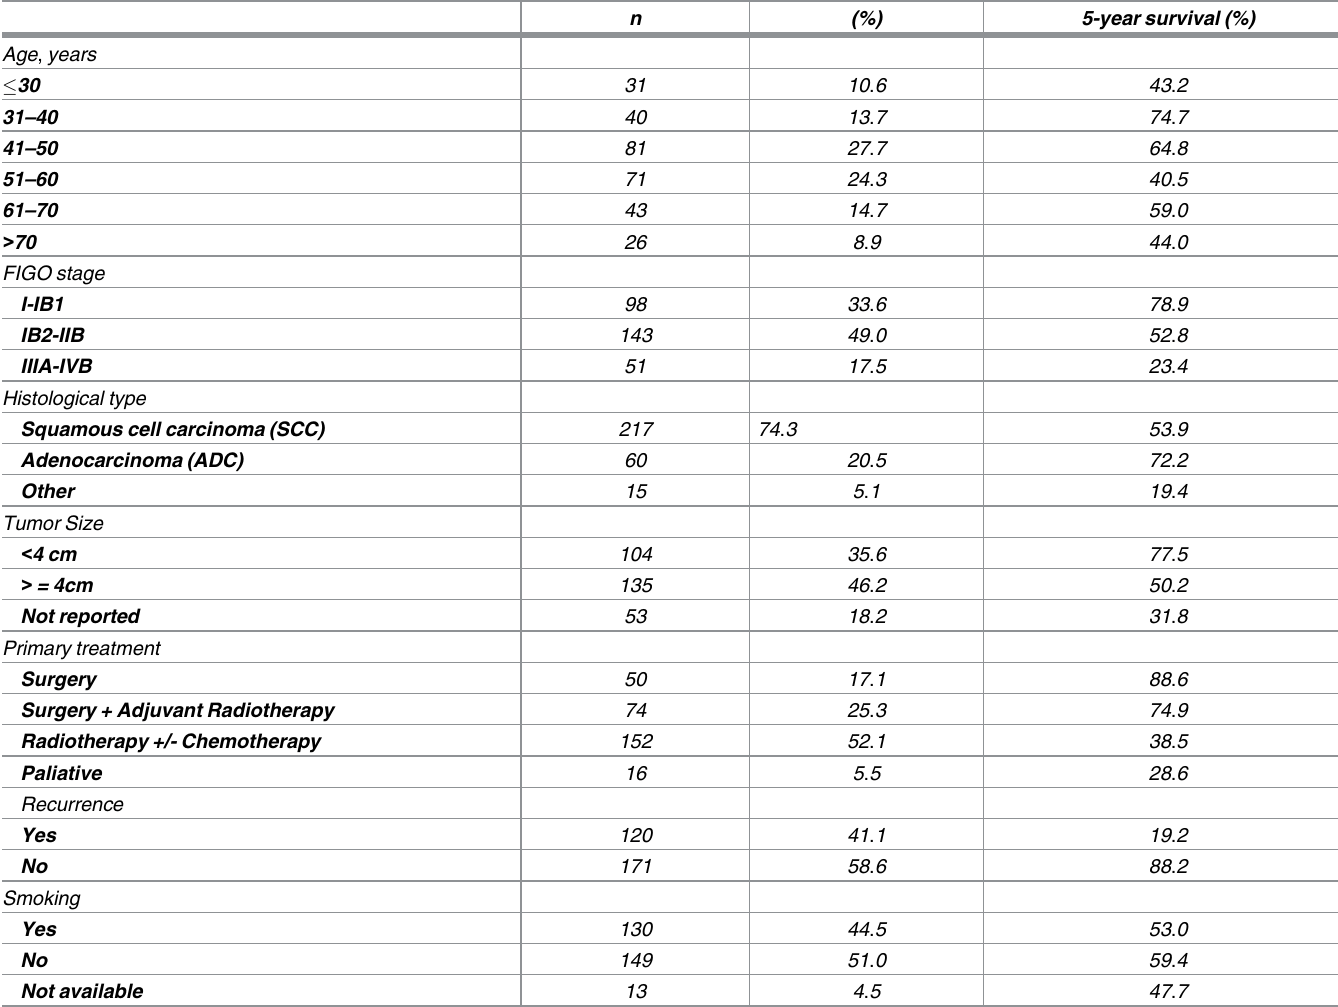
Table 1. Clinical and pathological parameters of all subjects with viable human